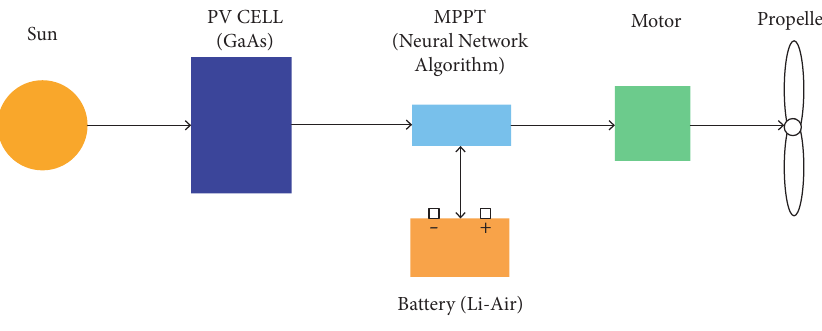
Figure 5. Proposed efficient power device in solar-powered applications.